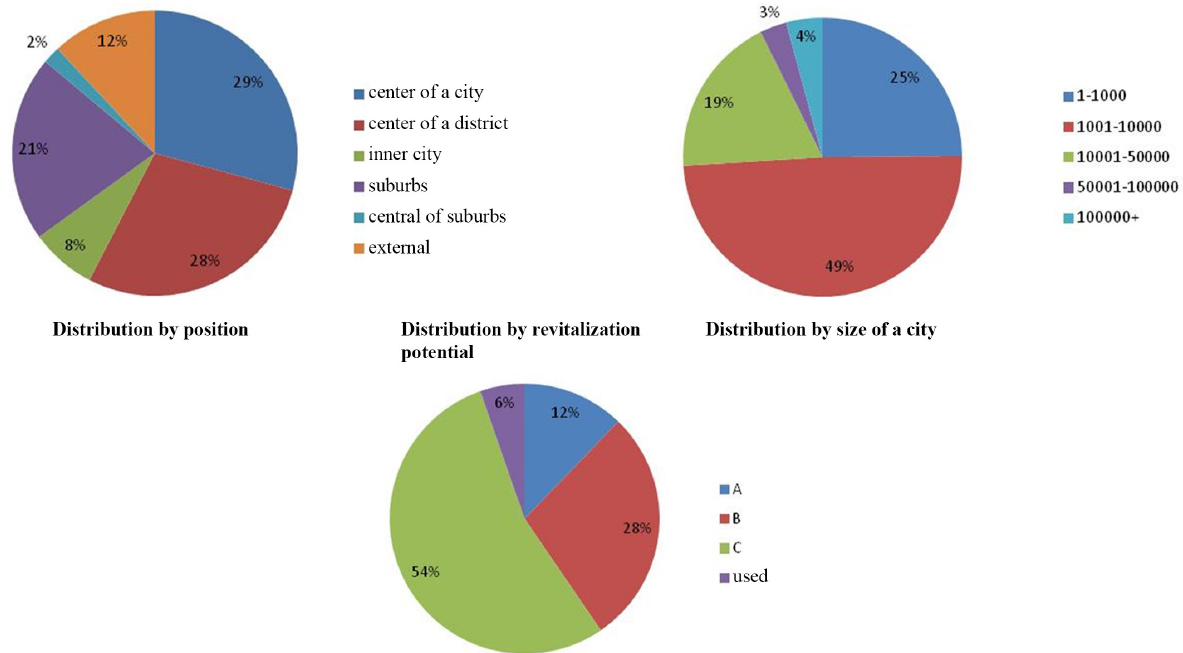
Figure 1. Distributions of railway areas (author’s